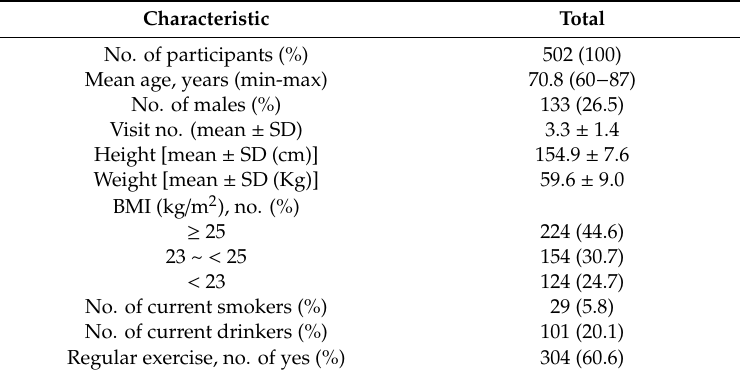
Table 1. Demographic characteristics of participants at the first